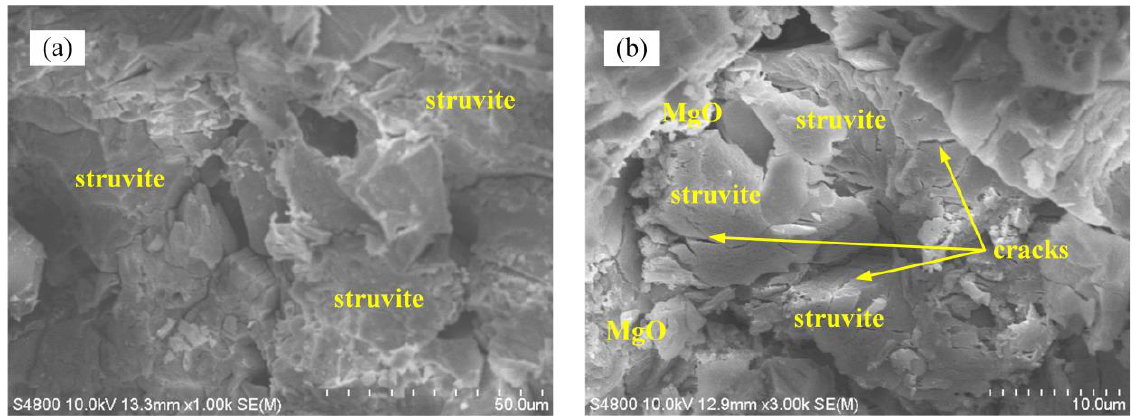
Figure 21. SEM microstructure of MPC at 28 d: ( a ) 1000 magnification, ( b ) 3000 magnification.